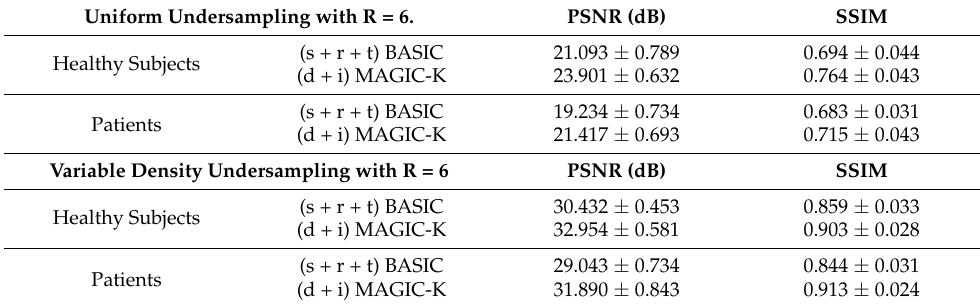
Table 1. PSNR and SSIM of the reconstructed images using data augmentation strategies of (s + r + t) BASIC and (d + i) MAGIC-K. The tests were applied on the healthy subjects and tumor patients. R stands for the acceleration